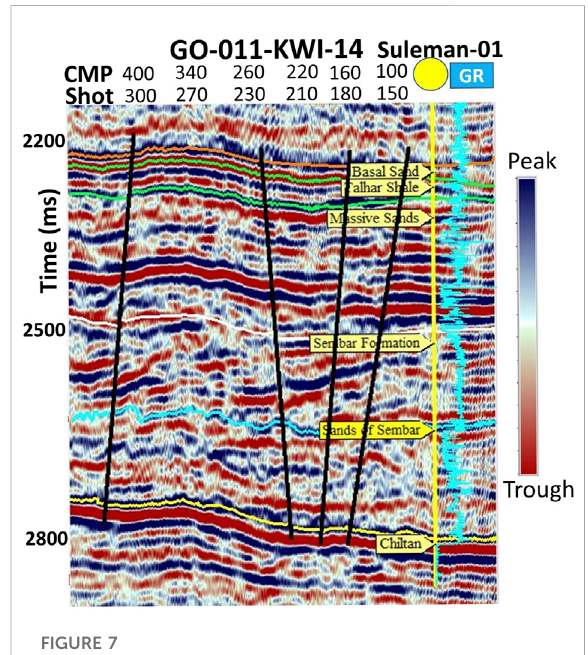
FIGURE 7 Interpreted seismic line O-011-KWI-14 of the Khewari block with GR log superimposed on it along with marked horizons and faults on it.